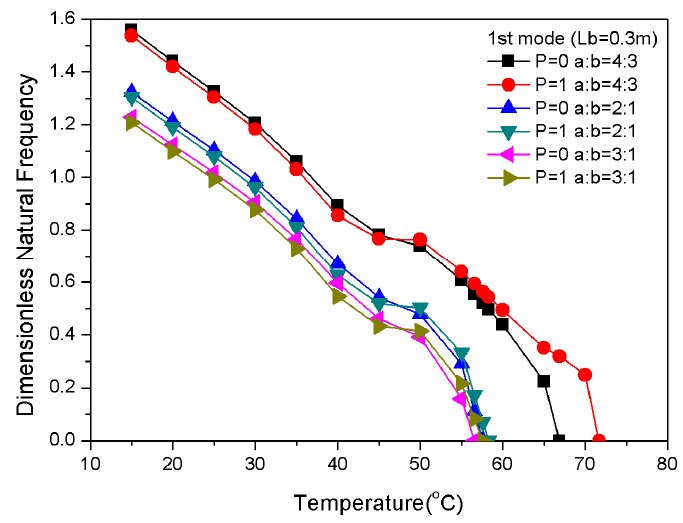
Figure 12. Dimensionless natural frequencies vs. temperature with variations of length.